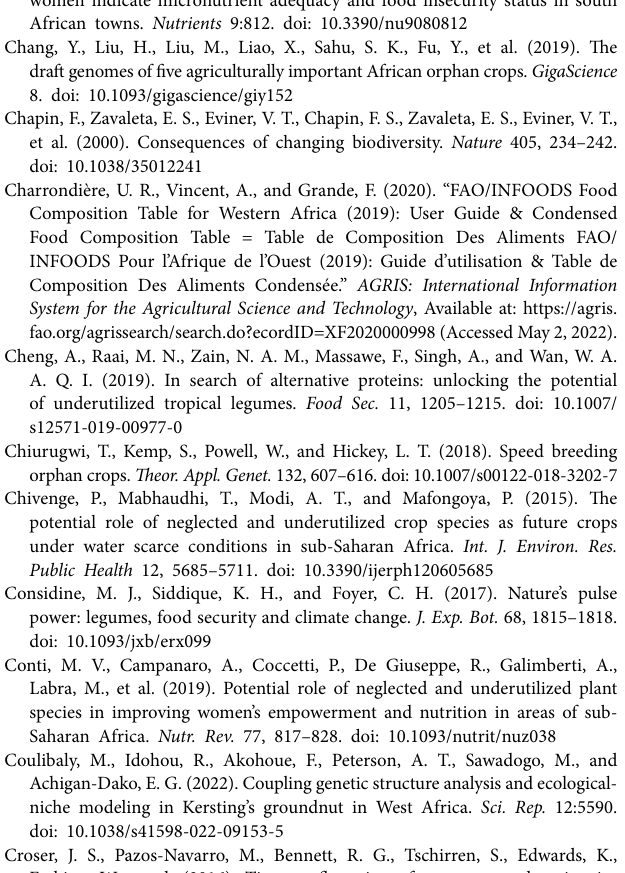
Composition Table for Western Africa (2019): User Guide & Condensed Food Composition Table = Table de Composition Des Aliments FAO/ INFOODS Pour l’Afrique de l’Ouest (2019): Guide d’utilisation & Table de Composition Des Aliments Condensée.” AGRIS: International Information System for the Agricultural Science and Technology , Available at: https://agris. fao.org/agrissearch/search.do?ecordID=XF2020000998 (Accessed May 2,